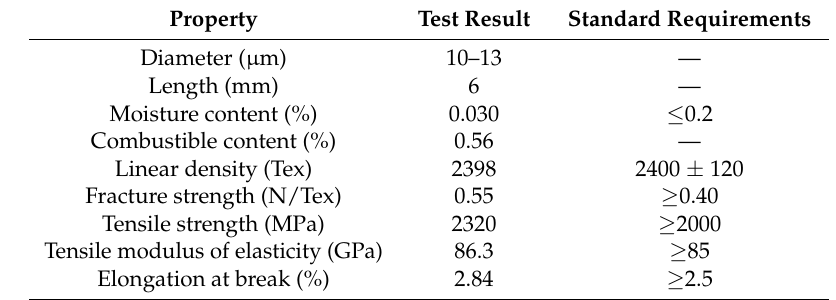
Table 4. Technical properties of basalt fiber.